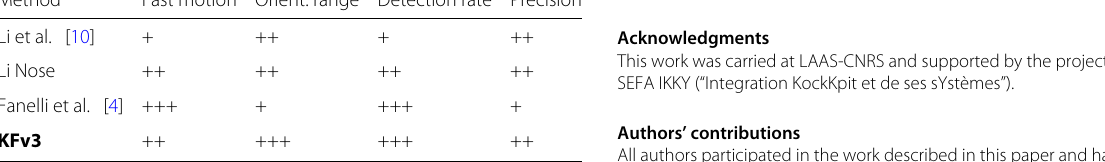
Table 7 Evaluation summary of each head pose estimator